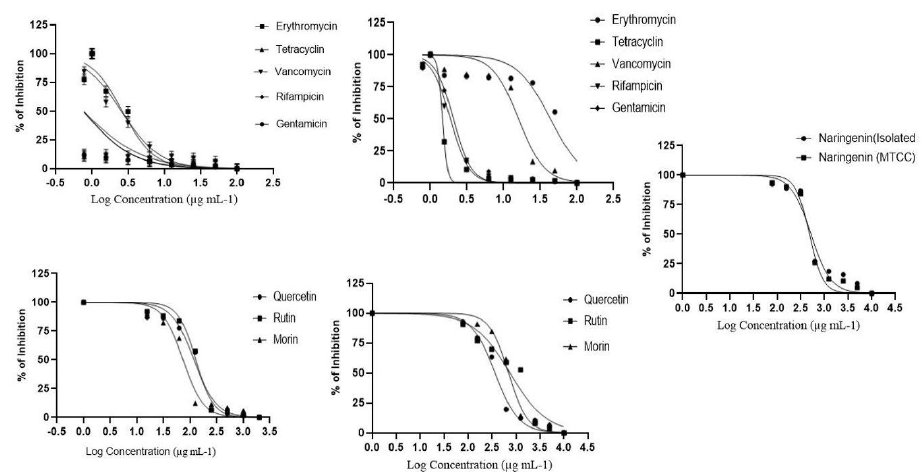
Fig. 1. Effect of antibiotics and flavonoids against the planktonic cells of S.aureus (Dose-response - inhibition curve). A - MTCC strain and B - Isolated strain for antibiotics, C - MTCC strain and D - Isolated strain for flavonoids, and E - Naringenin for both